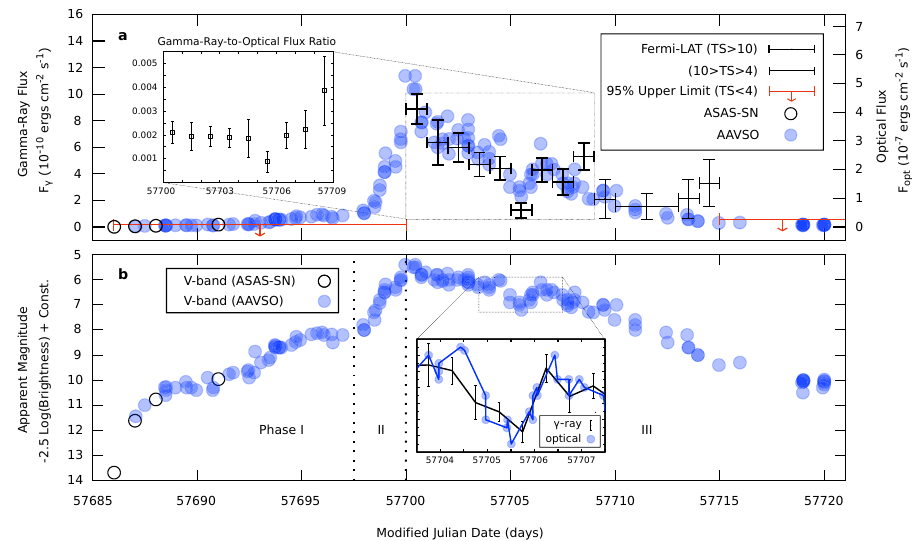
Figure 7. The top panel ( a ) shows the γ -ray (black and gray crosses, and red arrows) and bolometric (blue and black circles) light curves of ASASSN-16ma in flux units of ergs cm − 2 s − 1 , using observations from Fermi LAT and ASAS-SN/AAVSO. The bottom panel ( b ) shows the V-band light curves of the same optical datasets on a magnitude (logarithmic) scale. The inset box in ( b ) zooms in on the emission dip at MJD 57705 in γ rays and optical, which directly show the co-variance of the γ -ray and optical emission on time-scales as short as 0.5 days [33]. ( c (cid:13) Springer Nature. Reproduced with